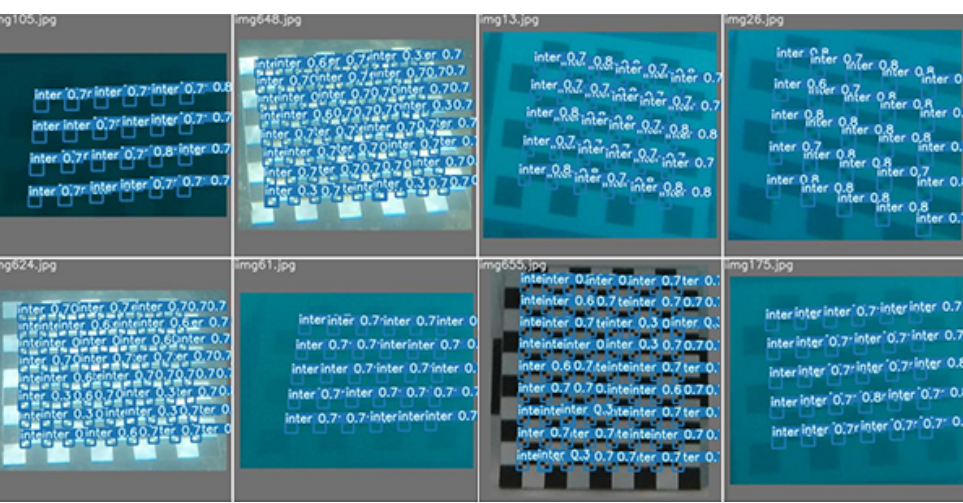
Figure 6. Examples of bounding boxes detected by YOLO that represent the intersections of chess- boards in cropped underwater